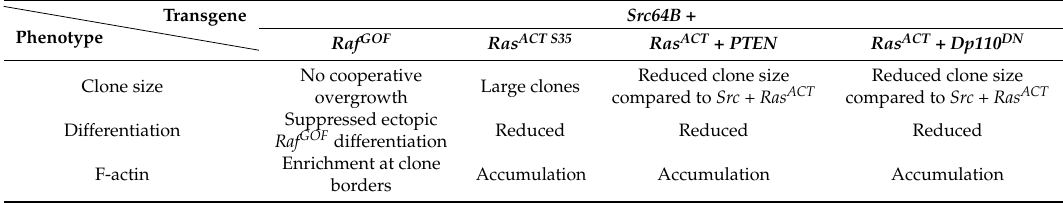
Table 4. Summary of phenotypes of ey-FLP MARCM third instar eye clones expressing Src64B with indicated